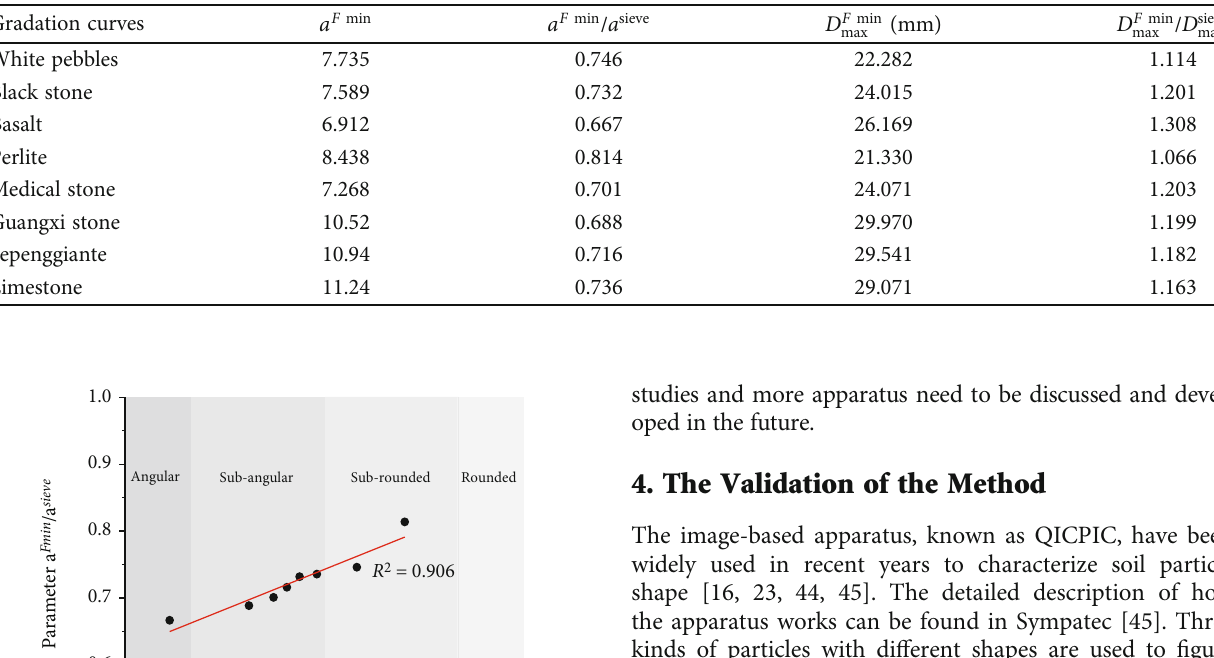
Table 4: The values of a F min and D F min for each kind of gradation